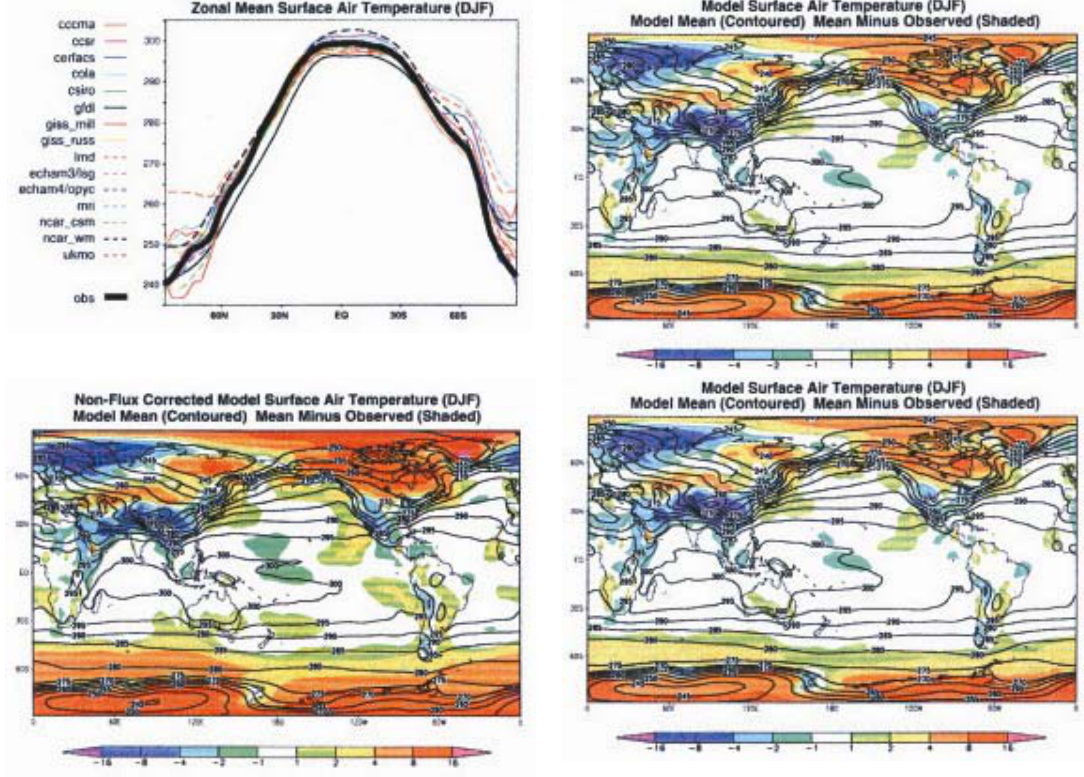
FIGURE 14. December-January-February climatological surface air temperature in °K simulated by the CMIP1 model control runs. Averages over all models (upper left), over all flux adjusted models (lower left) and over all non-flux–adjusted models (lower right) are shown together with zonal mean values for the individual models (upper right). Observed value is shown in the zonal mean plot (thick solid line), and the difference between “average model” and observation is shown on the longitude-latitude maps. (From Lambert and Boer 2000)